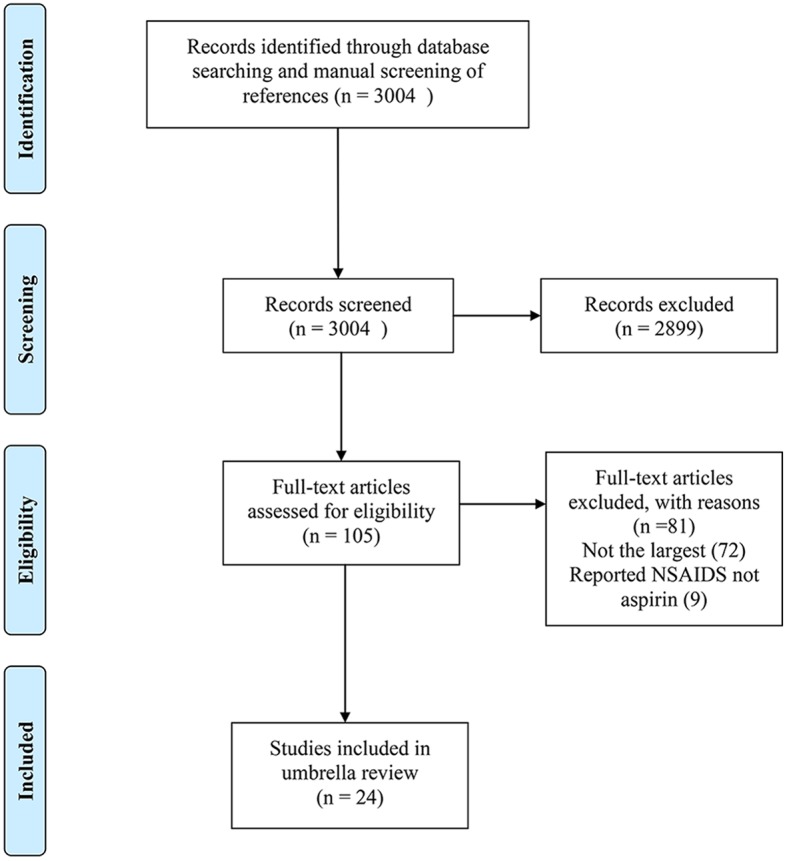
The flow diagram of study selection.